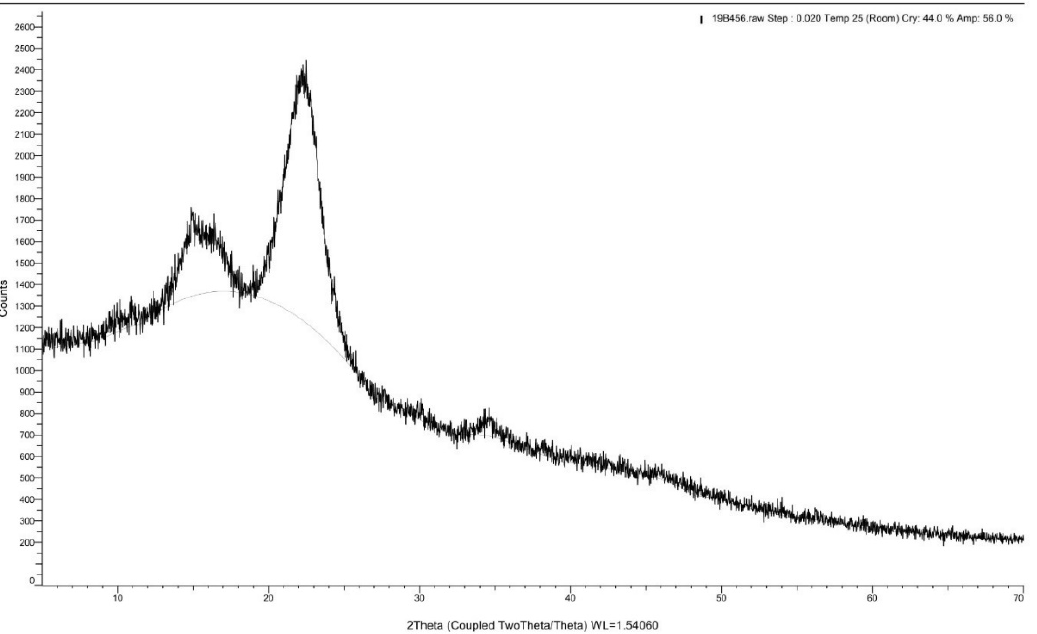
Figure 6. X-ray diffraction spectrum for Rhizophora spp. particleboard bonded with 12% binders Reprinted with permission from ref. [7].